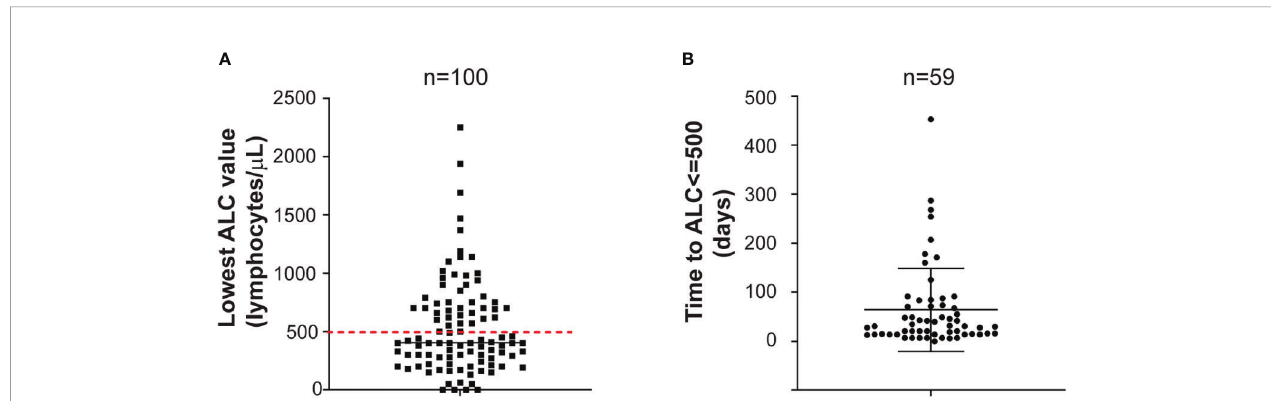
FIGURE 1 | (A) Lowest absolute lymphocyte count. Lowest absolute lymphocyte (ALC) value in the entire cohort of MM patients treated with daratumumab-based regimens (n = 100) is shown. Red dashed line is set at 500 lymphocytes/ m l, representing the threshold for severe lymphopenia. Mean with standard deviation are shown. (B) Time to severe lymphopenia. Time is calculated from ALC at starting daratumumab to ALC less or equal to 500 lymphocytes/ m l in the group of MM patients who developed severe lymphopenia (n = 59). Time is in days. Mean with standard deviation are shown.